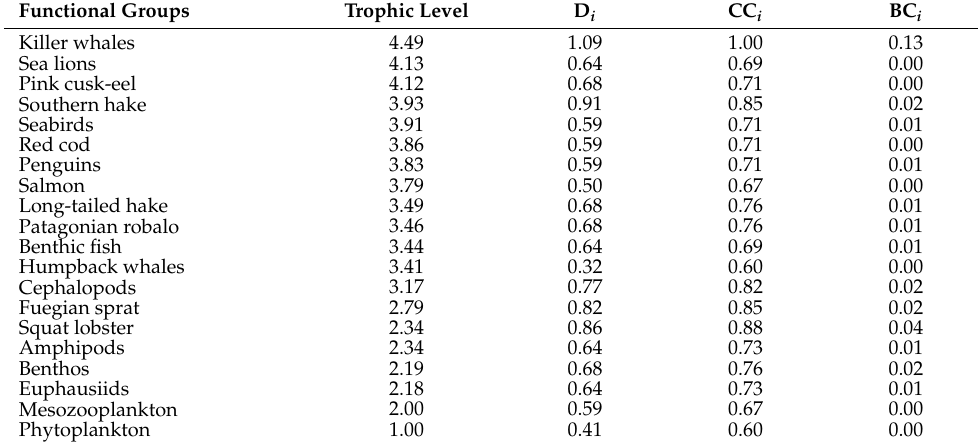
Table 4. Trophic level and functional indices of each ecosystem group in the Francisco Coloane Marine Area ecosystem.